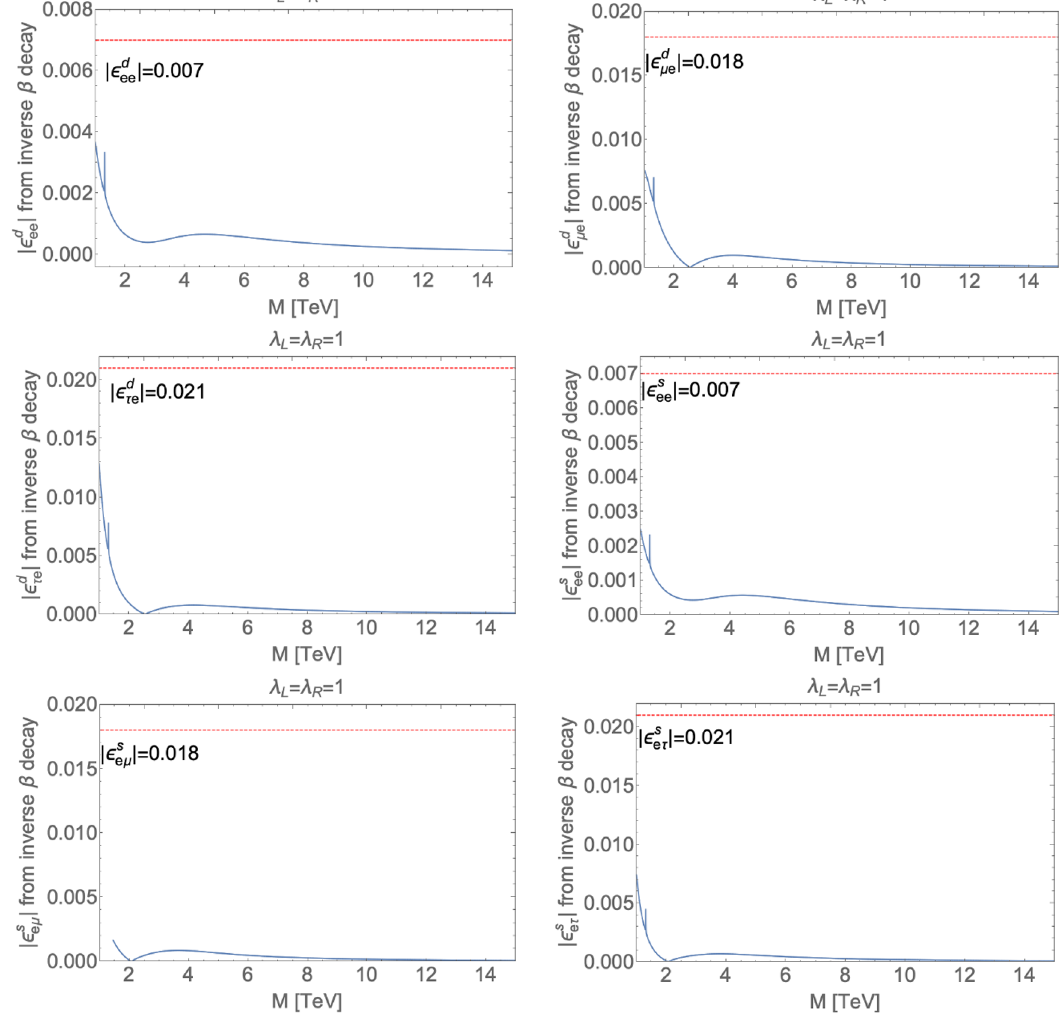
Figure 4 . Constraints on the simplified scalar leptoquark model from the neutrino NSI parameters from beta decay and inverse beta decay. The horizontal red dashed line in each plot corresponds to the current upper bound on the NSI parameter, and the blue curve corresponds to theoretical prediction from this simplified